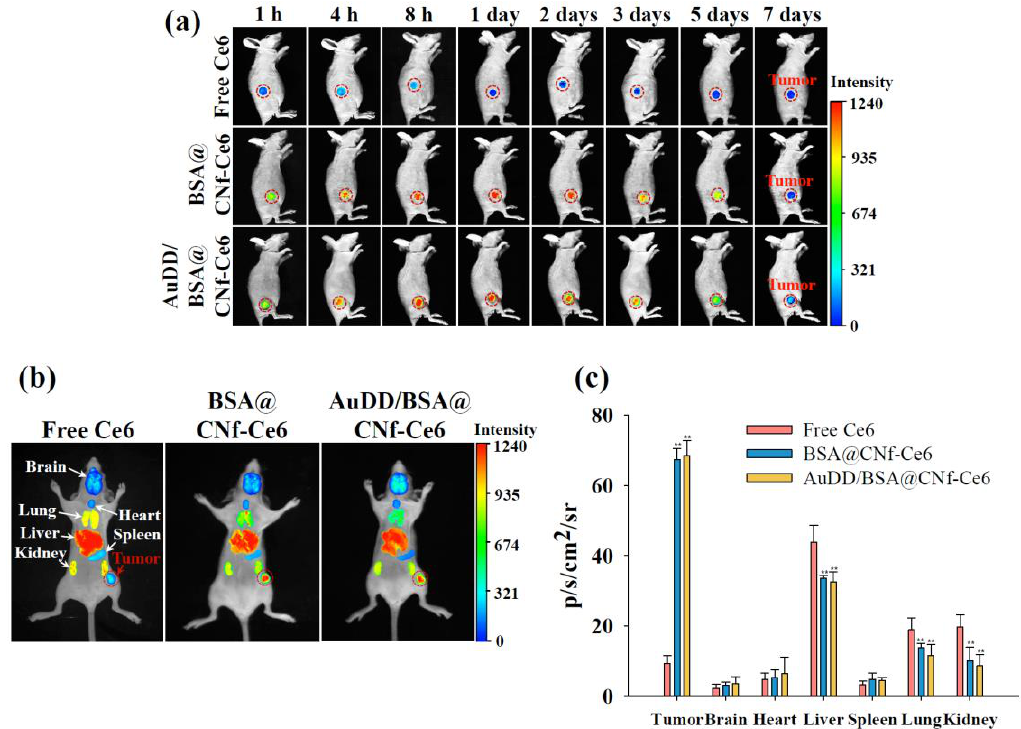
Figure 9. ( a ) In vivo non-invasive photoluminescent tumor images of free Ce6, BSA@CNf-Ce6, or AuDD / BSA@CNf-Ce6 injected intravenously into MDA-MB-231 tumor-bearing nude mice. Fluorescent tumor images were obtained for 7 d post-injection. Tumor sites are indicated by the dashed circles. ( b ) Fluorescence images of free Ce6, BSA@CNf-Ce6, or AuDD / BSA@CNf-Ce6 into organs harvested from MDA-MB-231 tumor-bearing nude mice at 8 h post-injection. ( c ) Total photon counts per centimeter squared per steradian (p / s / cm 2 / sr; measured using an Image Station 4000 MM) of the organs harvested from MDA-MB-231 tumor-bearing nude mice at 8 h post-injection (mean ± SD, n = 5, ** p < 0.01 compared to free